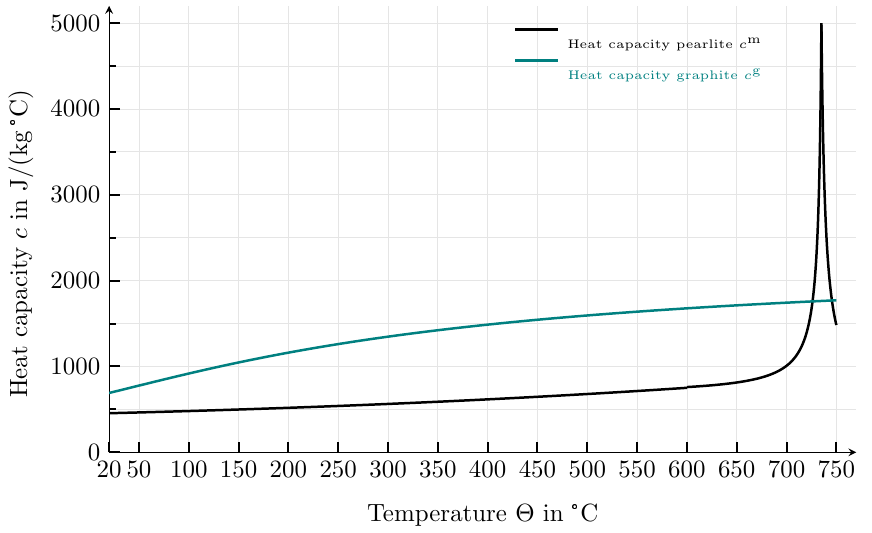
and λ g , according to Helsing texthexa hex c −